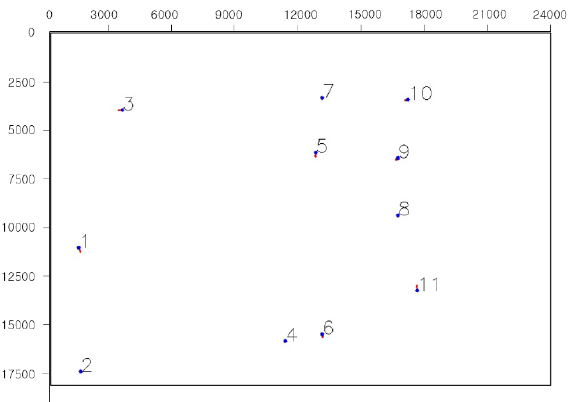
Figure 5. Geometric errors of check point - Seoul